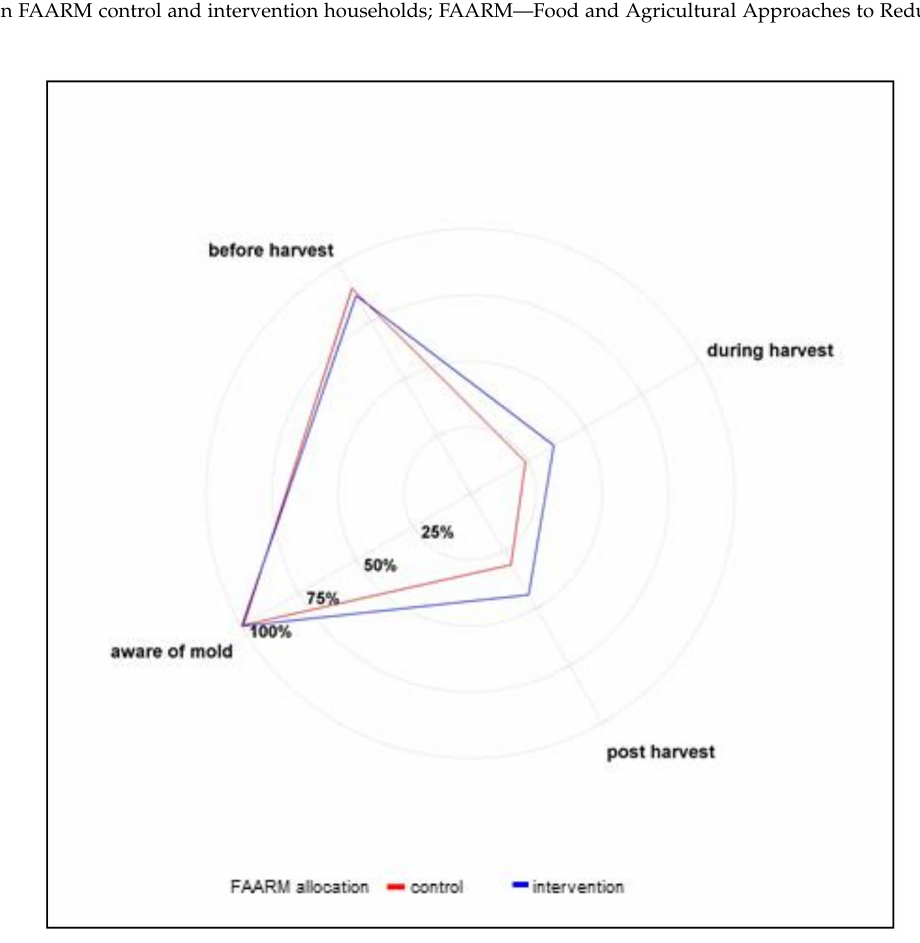
Figure 1. Awareness and timing of mold contamination ( n =